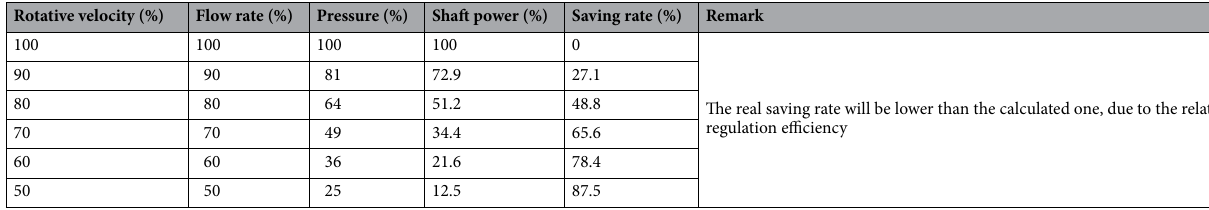
Table 3. Performance of centrifugal load-type speed regulation.